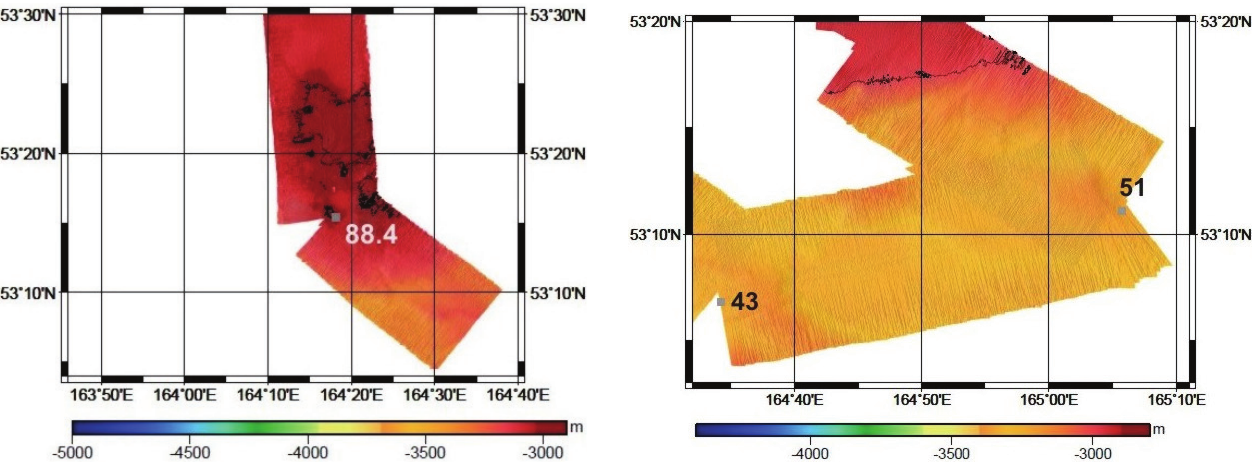
Fig. 8. Area 14: bathymetry and position of heat flow stations and heat flow values in mWm − 2 as measured during cruise SO201-2 (values in white or black). This terrain is flat in comparison to area 13, its subsurface presumably tectonically less disturbed. Regional heat flow is lower than in area 13, indicating absence of natural convection in the subsurface. Map was provided by B. Baranov (personal communication, 2009).